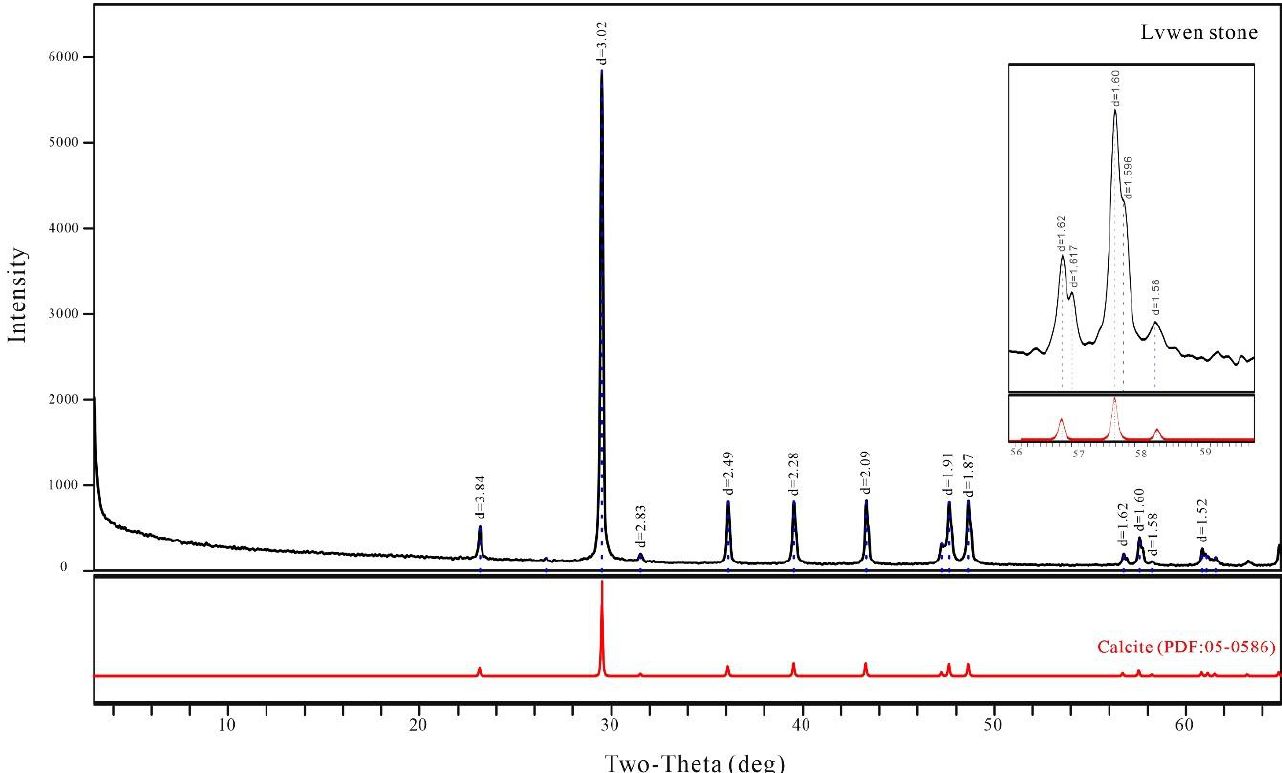
Figure 4. X-ray diffraction pattern of cabochon specimen S 1 of Lvwen stone.